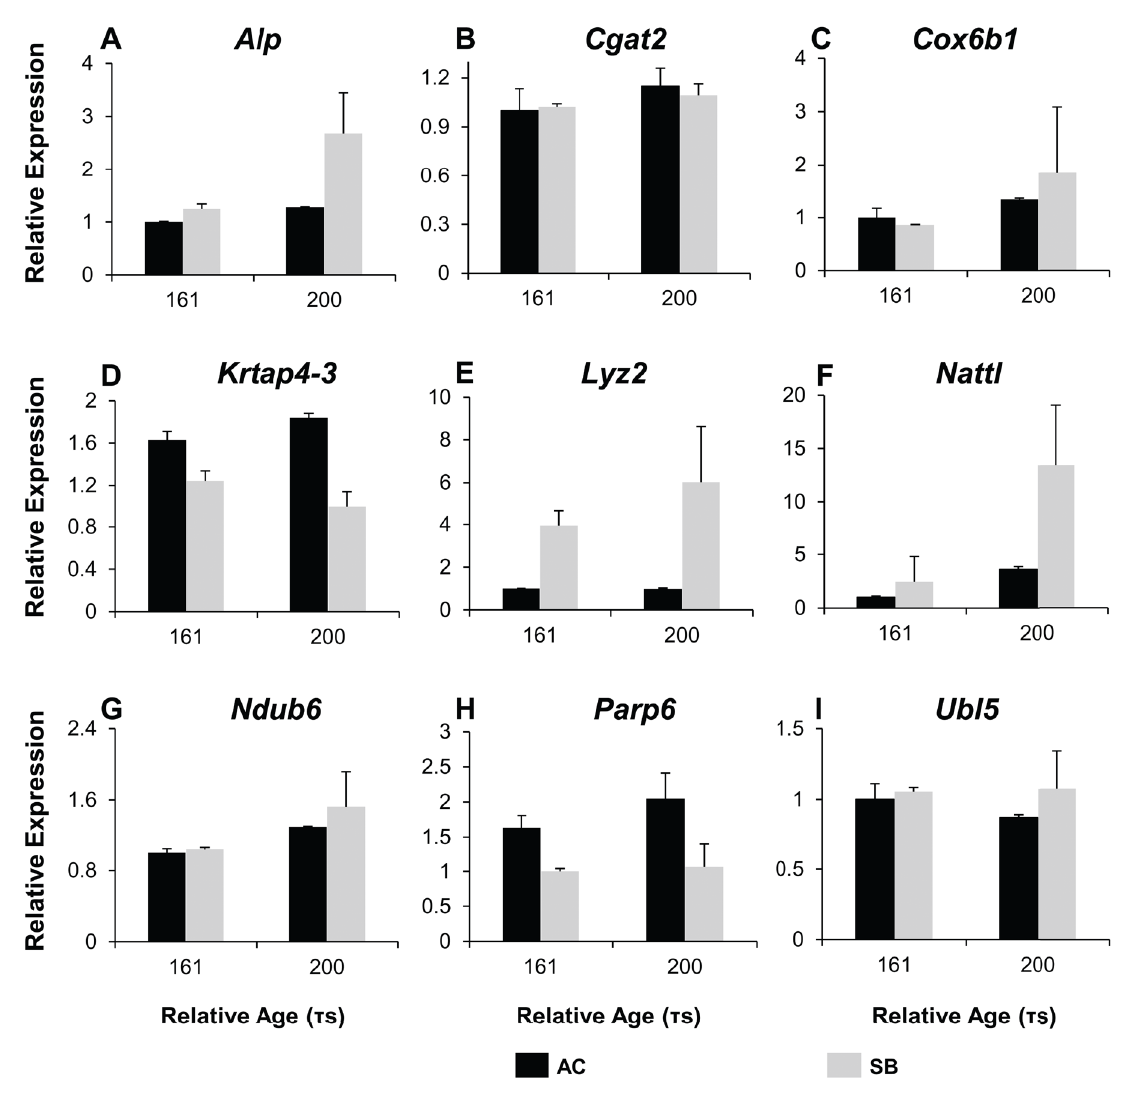
Figure 4. qPCR validation of candidates from transcriptome in whole embryos of Arctic charr. Relative expression of 9 genes ( A – I ) analysed by qPCR in the small benthic (SB) charr from Lake Thingvallavatn and aquaculture (AC) charr at two different developmental timepoints (161 and 200 τ s ). 5 genes were differentially expressed between the two morphs ( Alp, Krtap4-3, Lyz, Nattl, Parp6 ), while 4 further genes did not show significant expression differences between morphs ( Cgat2, Cox6B1, Ndub6, Ubl5 ), see S4 Table. Error bars represent standar d deviation calculated from two biological